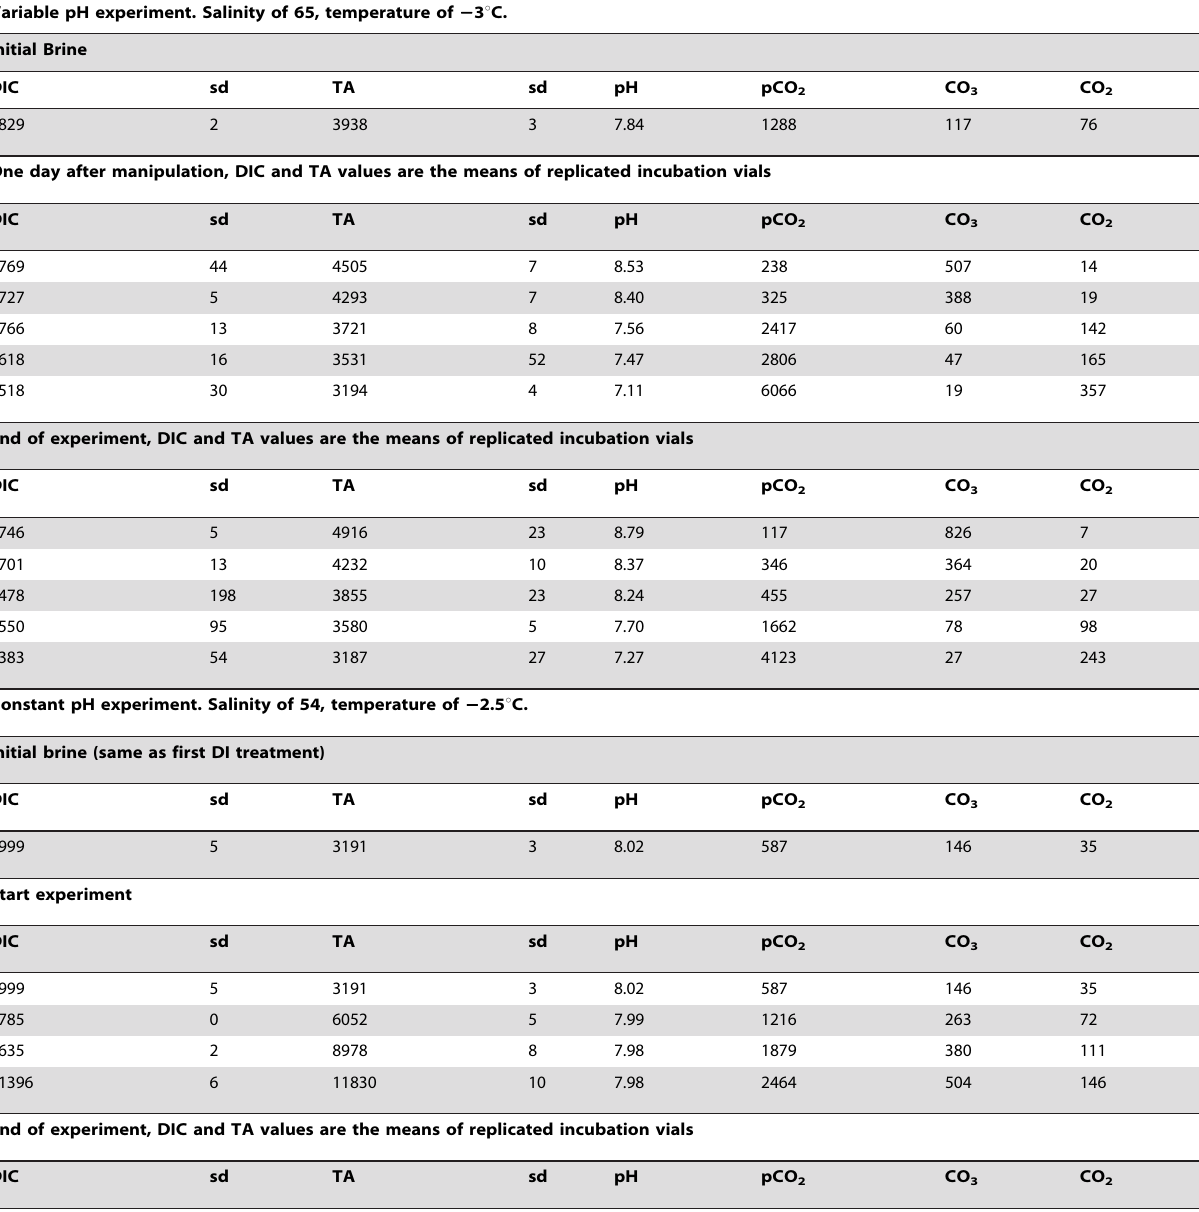
Variable pH experiment. Salinity of 65, temperature of 2 3 u